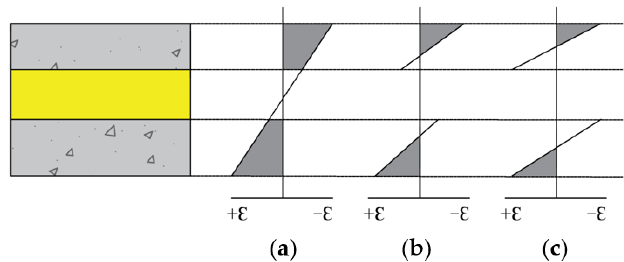
Figure 1. Sectional strain distribution of the sandwich panel: ( a ) Complete composite; ( b ) Partial composite; ( c ) Non-composite.